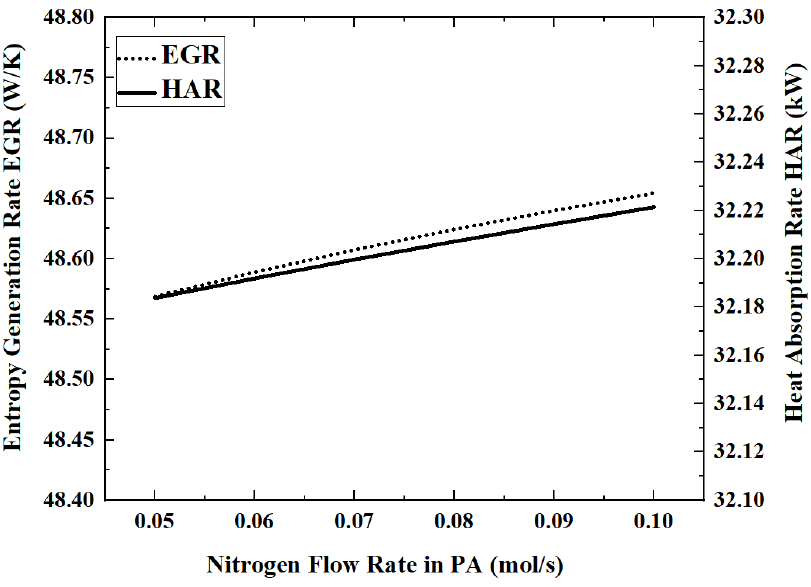
Figure 13. Effect of nitrogen flow rate on EGR and HAR.